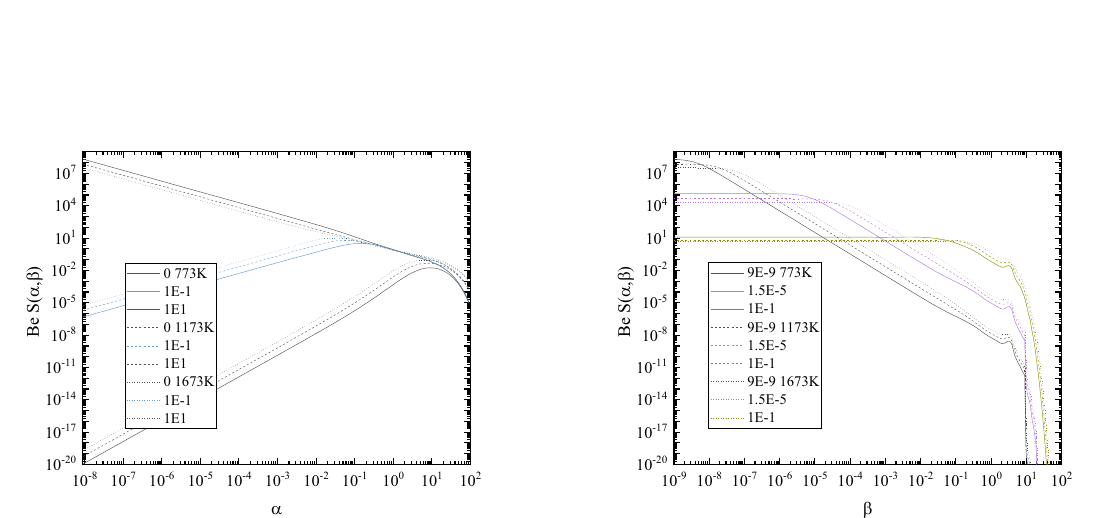
Figure 3. TSL vs . α (left, for various β values) and TSL v. β (right, for various α values) for Be in FLiBe at 773 K, 1173 K, and 1673 K.